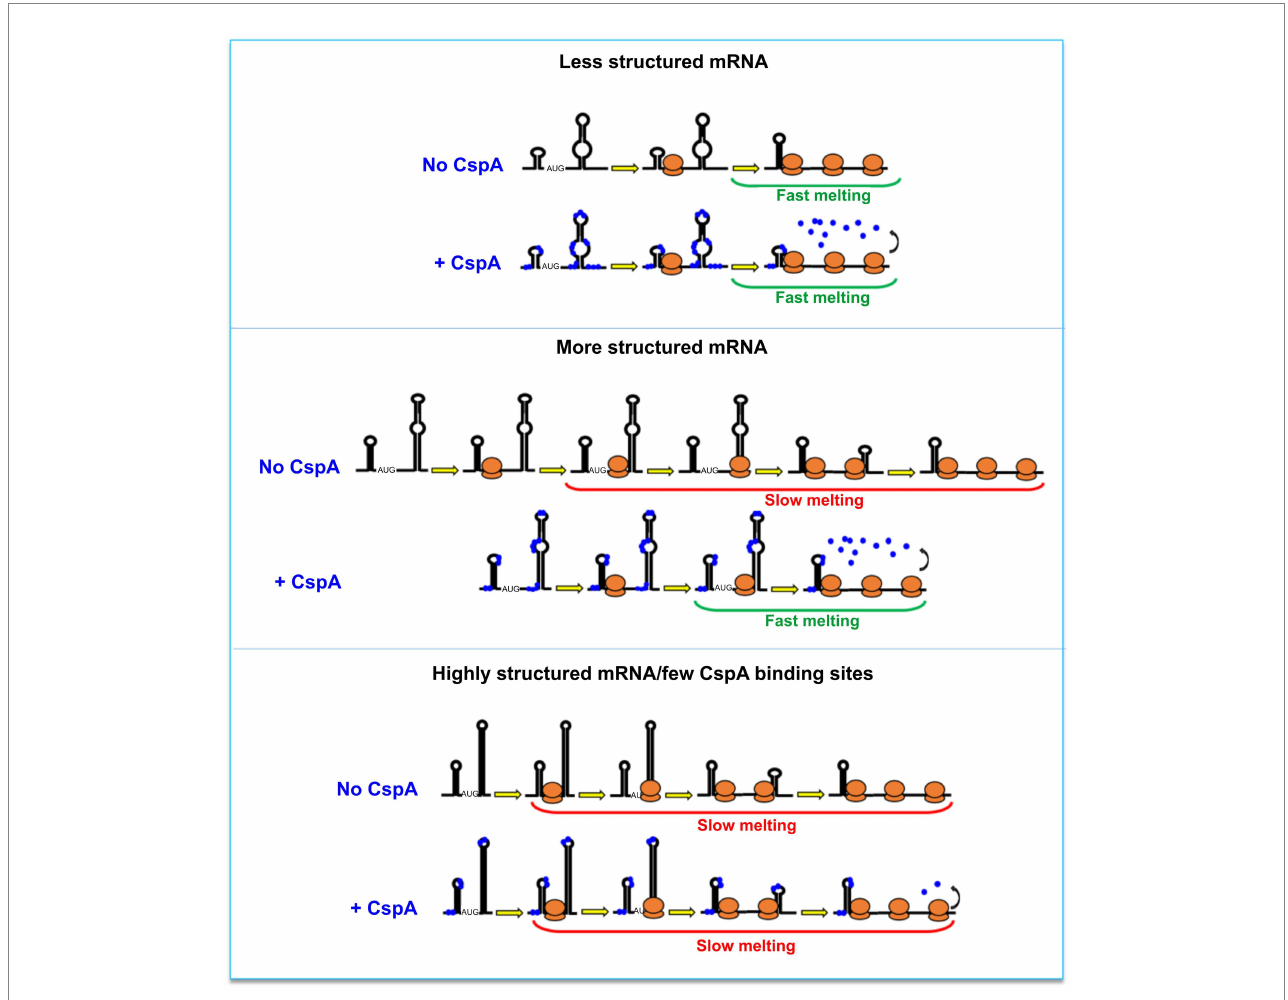
FIGURE 6 The CspA paradox. CspA would ensure ribosome progression by maintaining the bound regions unstructured and/or destabilizing the helices when ribosomes translate along the mRNA (middle panel). This effect will not be seen with mRNAs attaining an open conformation compatible with translation at low temperature (top panel), or in the case of mRNAs that are either structured or containing few sites suitable for CspA binding (bottom panel). A possible model postulates that the destabilization of mRNA structures by CspA will facilitate ribosome progression. In another model, the amount of the mRNA- bound CspA increases as the translating ribosomes open up the mRNA